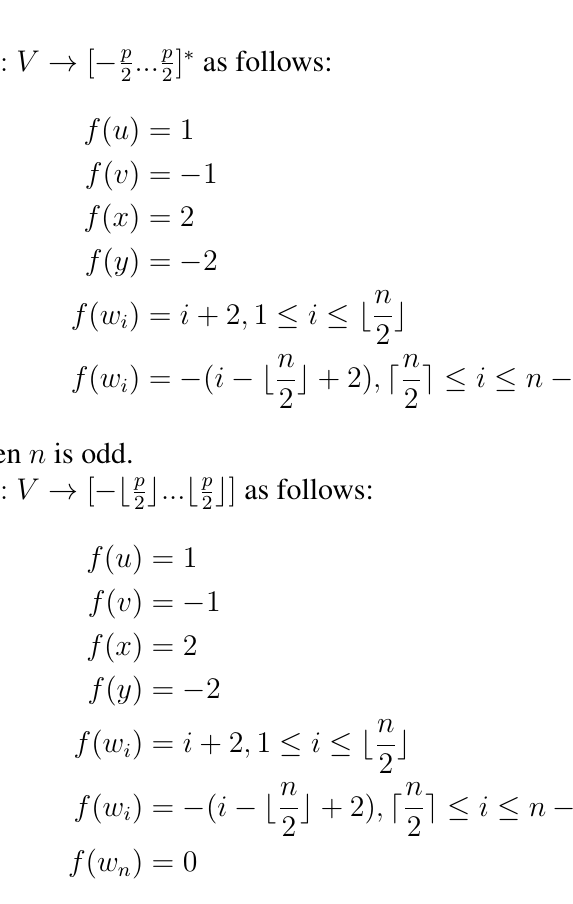
Figure 3: Integer cordial labeling of T